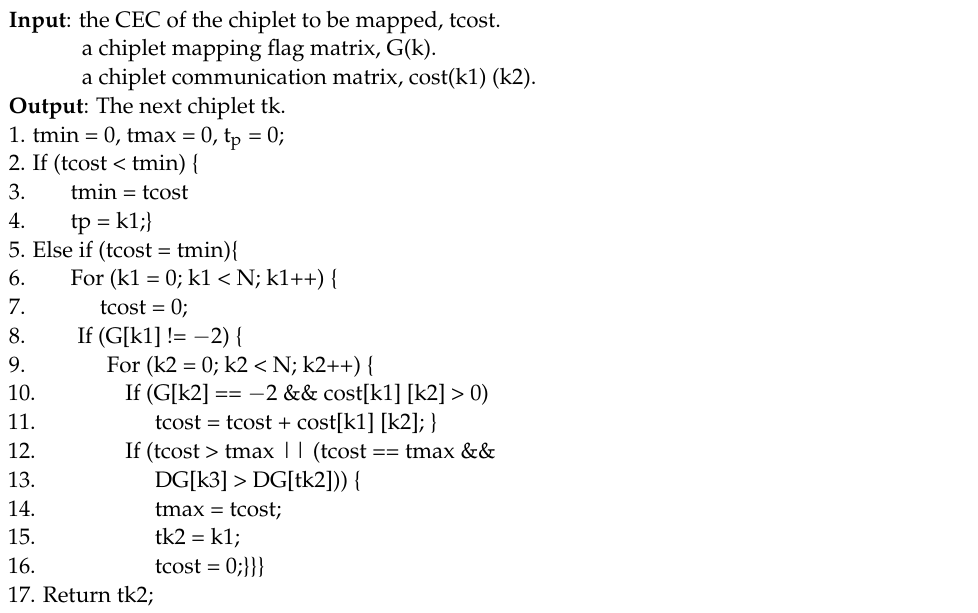
Algorithm 3 Secondary local exploration algorithm